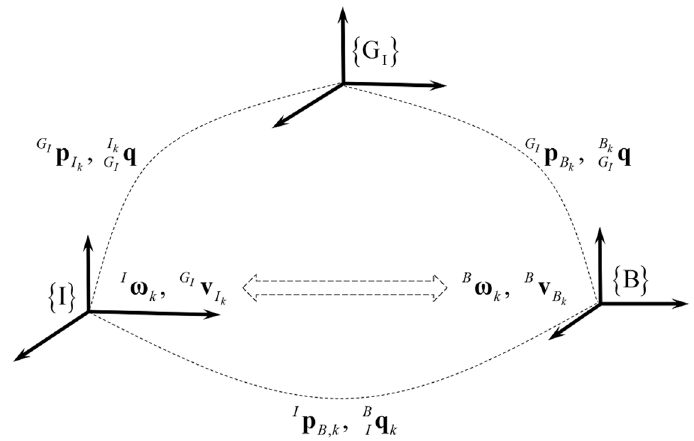
I q denotes the rotation quaternion from {G I } to {I} Figure 1. The lever arm effect between {B} and {I}. k Figure 1. The lever arm e ff ect between {B} and {I}. I k q denotes the rotation quaternion from {G I } to G G I I G B p denotes the position of {I} in {G I } at time k t . k q denotes the rotation quaternion from q denotes the rotation quaternion {I} at time t k ; G I p denotes the position of {I} in {G I } at time t k . B k at time k t ; I I G I k G I k I q k and I p from {G I } to {B} at time t k ; G I p denotes the position of {B} in {G I } at time t k . B denote the G I p denotes the position of {B} in {G I } at time k t . B I k q and p denote the {G I } to {B} at time k t ; I B k I B , k B , B k k rotation and translation extrinsic parameters between {B} and {I} at time t k , respectively. G I v denotes G v rotation and translation extrinsic parameters between {B} and {I} at time k t , respectively. I I k I k the velocity of {I} in {G I } at time t k ; B v denotes the vehicle velocity at time t k . I ω k and B ω k denote B B k v denotes the vehicle velocity at time k t . I ω and B ω denotes the velocity of {I} in {G I } at time k t ; B k k k the angular rates of {I} and {B} at time t k , denote the angular rates of {I} and {B} at time k t , respectively.